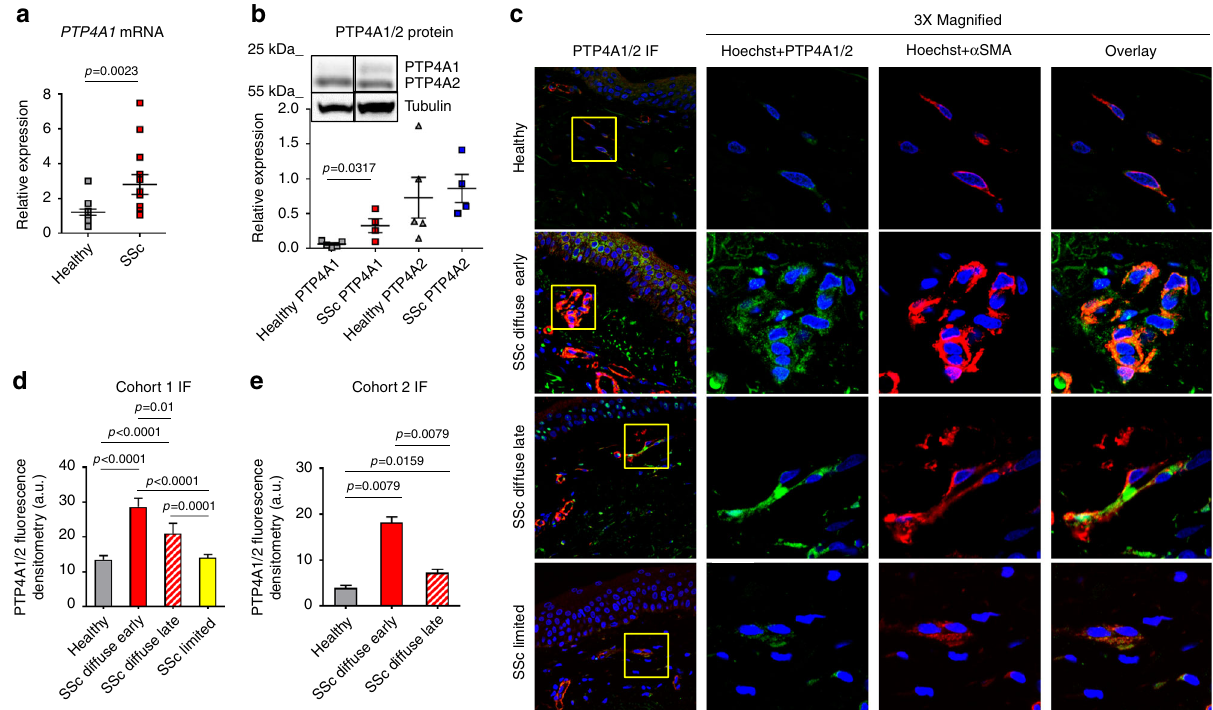
Fig. 1 PTP4A1 is overexpressed in SSc DFs. a Mean ± SEM of PTP4A1 mRNA expression measured in DF lines from 13 healthy donors or patients with SSc. b Mean ± SEM of densitometric scan expression plus representative immunoblotting for PTP4A1/2 (upper bands) normalized to α tubulin (lower bands) in fi ve healthy and four SSc DF lines. Images are from distinct membranes. c PTP4A1/2 (green signal) and α SMA (red signal) IF in skin sections from healthy or SSc diffuse early, diffuse late, and limited donors with Hoechst nuclear staining (blue signal). PTP4A1/2- α SMA co-localization signal appears orange in the images. Right panels show magni fi ed area from yellow squares in left panels. d , e Mean ± SEM of PTP4A1/2 fl uorescence densitometry signal in α SMA positive skin cells from two cohorts: the fi rst one d including six healthy or fi ve SSc diffuse early, six diffuse late and six limited donors; the second one e including fi ve healthy or fi ve SSc early and fi ve late donors. Mann – Whitney test. Scale bars, 50 μ